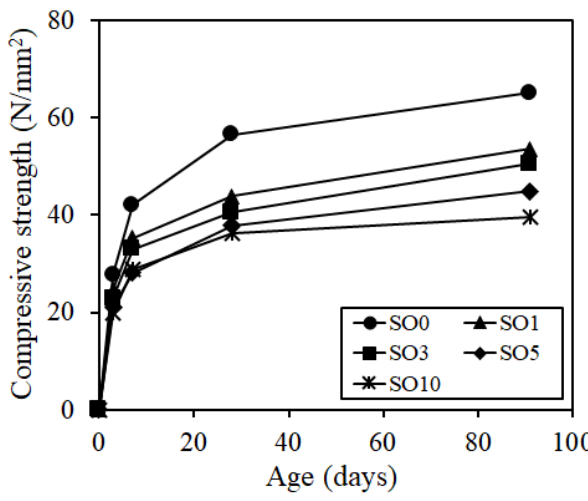
Figure 4. Compressive strength.